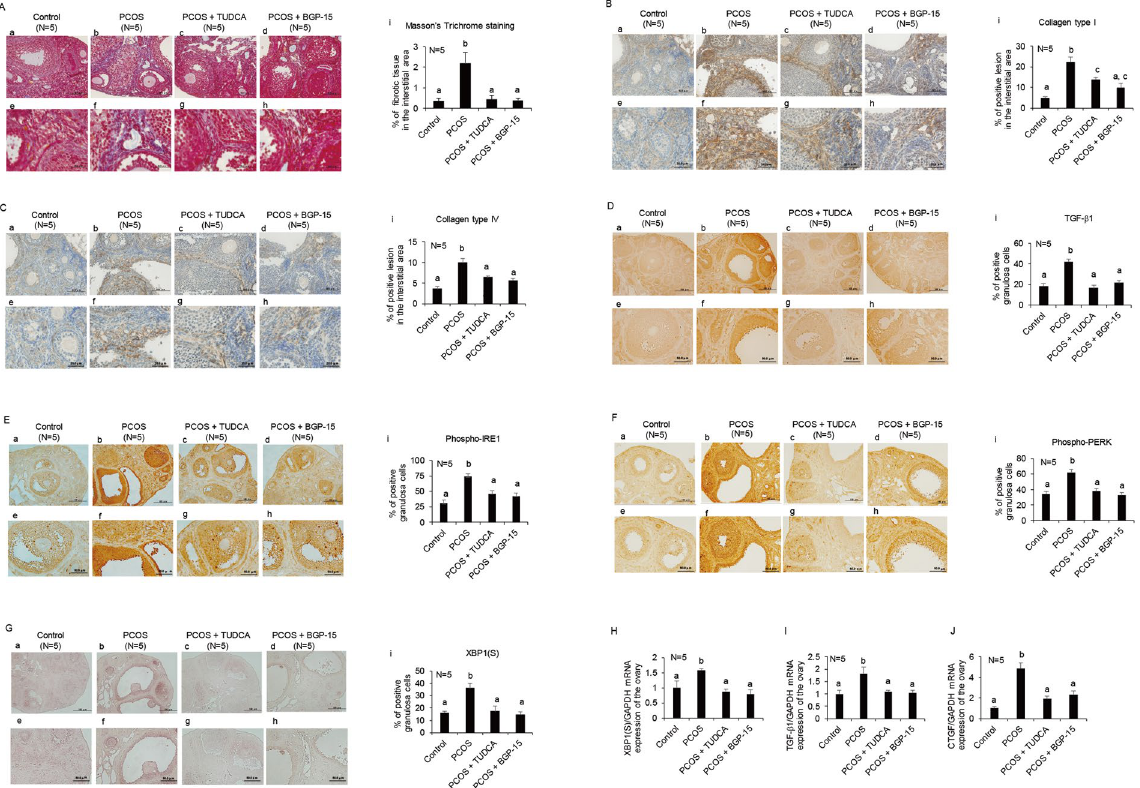
Figure 5. Effects of ER stress inhibitors on ovarian fibrosis in PCOS mice. Three-week-old female mice were divided into four groups. The control group (n = 5) was s.c. injected daily with sesame oil, followed by the oral administration of saline for 20 days. The PCOS group (n = 5) was s.c. injected daily with DHEA (6 mg/100 g of body weight), followed by the oral administration of saline for 20 days. The PCOS + TUDCA group (n = 5) was s.c. injected daily with DHEA, followed by the oral administration of TUDCA (50 mg/100 g of body weight) for 20 days. The PCOS + BGP-15 group (n = 5) was s.c. injected daily with DHEA, followed by the oral administration of BGP-15 (3 mg/100 g of body weight) for 20 days. The ovaries were collected on day 21. ( A ) Cross-sections of ovaries were stained with Masson’s trichrome stain. Fibrotic tissue was stained blue. ( B – F ) Cross-sections of ovaries were stained with collagen type I, collagen type IV, TGF- β 1, phospho-IRE1, and phospho-PERK. ( G ) Cross-sections of ovaries were hybridized with a DIG-labeled antisense XBP1(S) probe. ( A – G ) (a–h) show the representative sections. Lower panels (e–h) show highly magnified views corresponding to (a–d). (i) show the quantitative analysis of ( A ) Masson’s trichrome staining, ( B – F ) immunohistochemical staining, and ( G ) in situ hybridization. The scale bars in ( A – C ) (a–d) and ( A – C ) (e–h) indicate 50 μ m and 20 μ m, respectively. The scale bars in ( D – G ) (a–d) and ( D – G ) (e–h) indicate 100 μ m and 50 μ m, respectively. ( H – J ) XBP1(S), TGF- β 1, and CTGF mRNA expression levels in mouse ovaries were measured by real-time PCR and normalized to that of GAPDH. The letters denote significant differences between groups. TUDCA, tauroursodeoxycholic